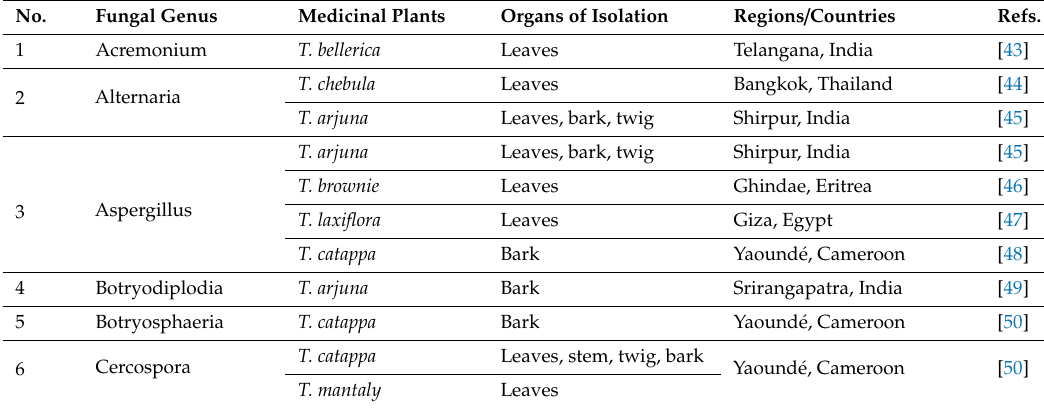
Table 1. Diversity of fungal genera isolated from Terminalia